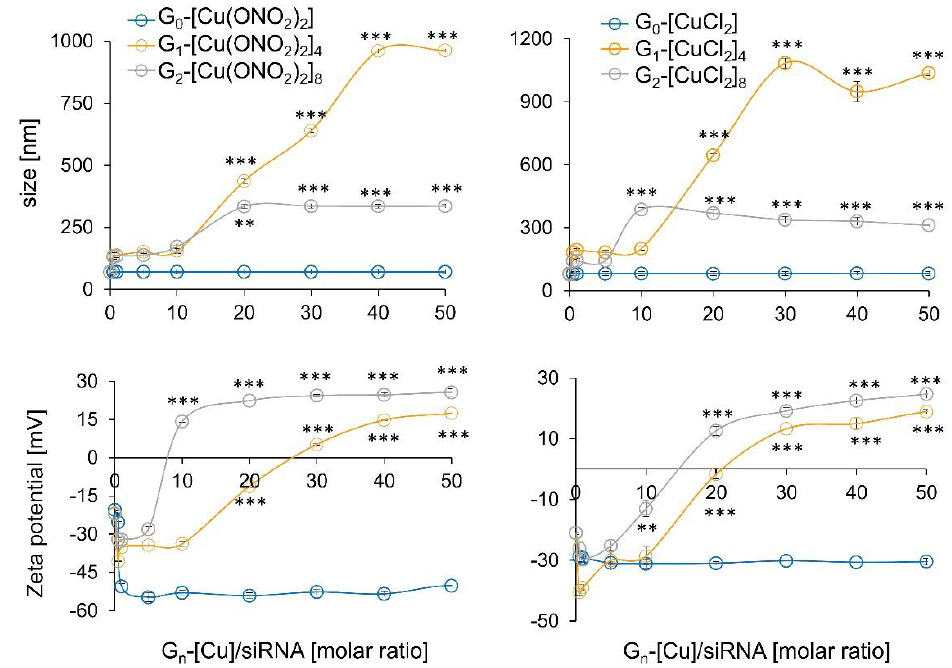
Figure 4. Zeta potential and zeta average size of G n -[Cu]/siRNA complexes at different molar ratios in water as a solvent. [siRNA] = 0.3 μM. Results were represented as mean ± standard deviation ( n = 3). Statistically significant differences compared to the control cells p ≤ 0 .01 (**); p ≤ 0 .001 (***).